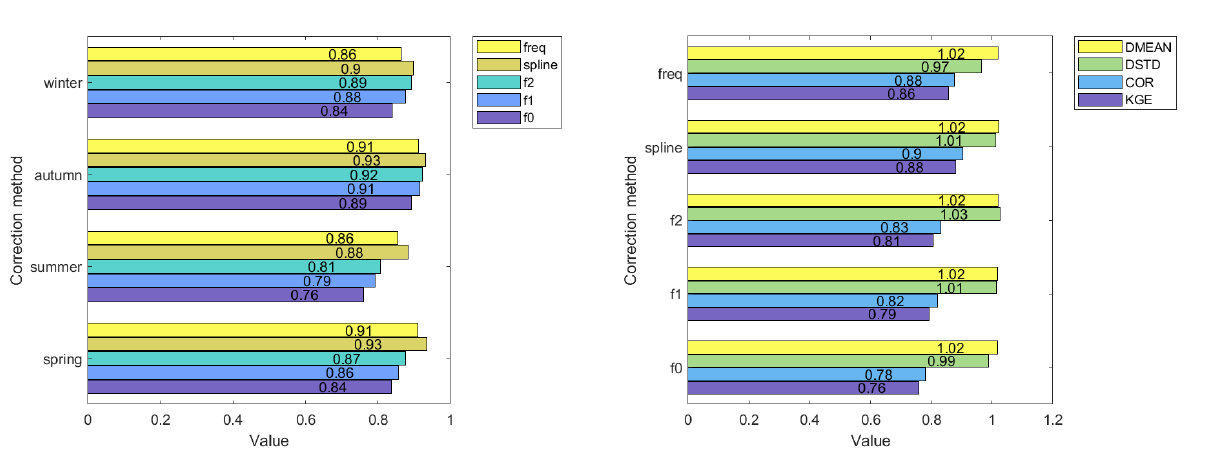
Figure 6. Validation results for the presented